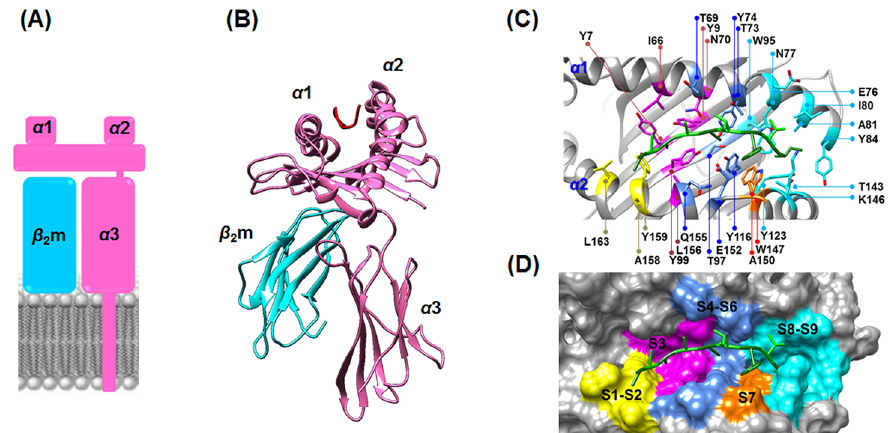
Fig 1. Structural basis of HLA class I. (A) Schematic model of HLA buried in the transmembrane. (B) HLA (pink) contains the α 1 and α 2 subdomains that contribute to the peptide binding groove, while α 3 is the C- terminal domain in complex with ß 2 -microgluobulin ( ß 2 m) as a noncovalently supported protein (cyan). (C) Ribbon and (D) van der Waals surface representations of the MICA-TM nonapeptide (green stick model) occupied in the peptide binding sub-sites (S1 – S9, shaded by different colors) of HLA-B * 51:01.